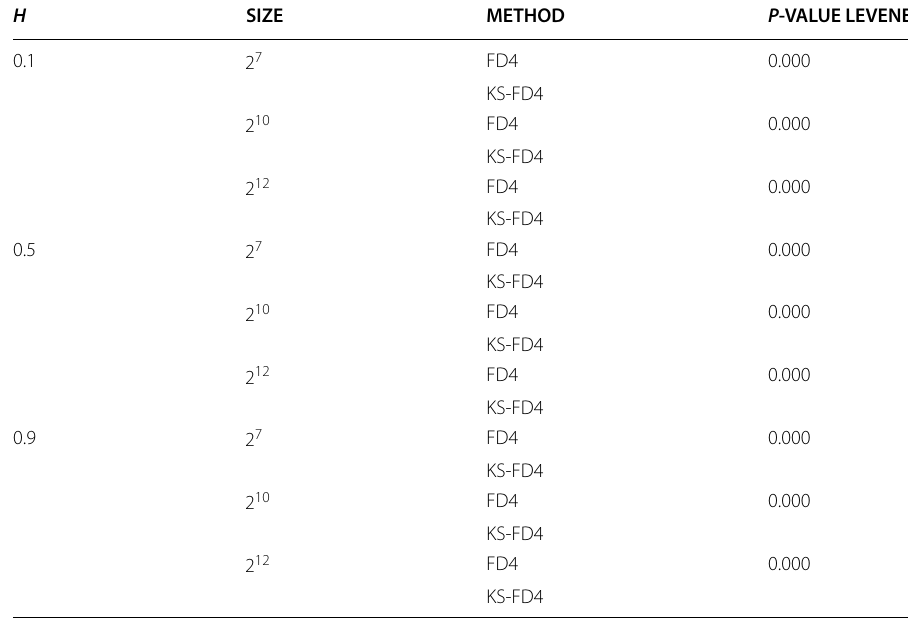
A p ‑value less than 0.01 means that the standard deviations of the two algorithms are significantly different